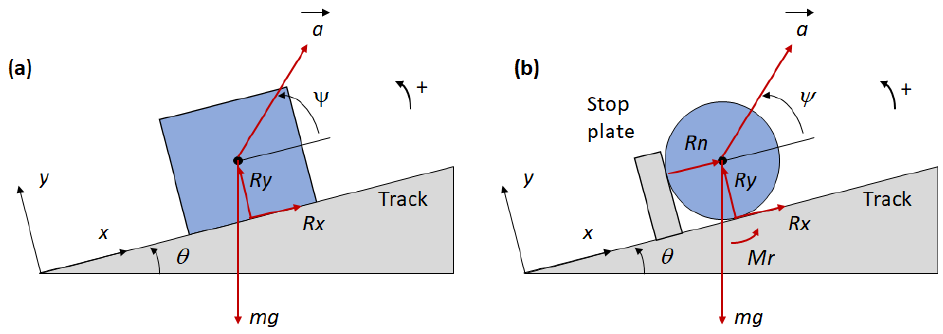
Figure 1. Block ( a ) and cylindrical part; ( b ) on the vibrating conveyor.